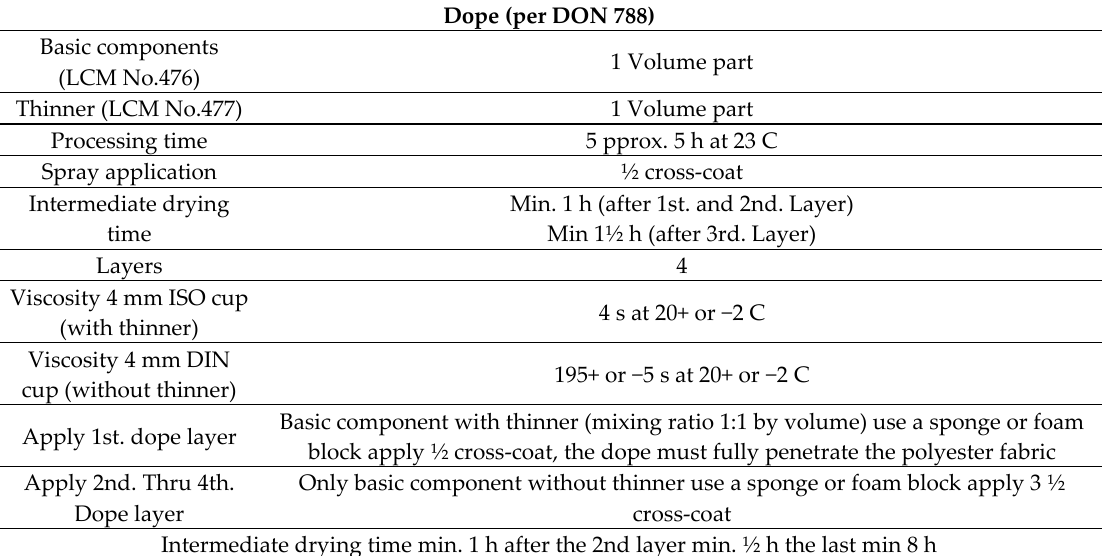
Table 2. Example of coating specification